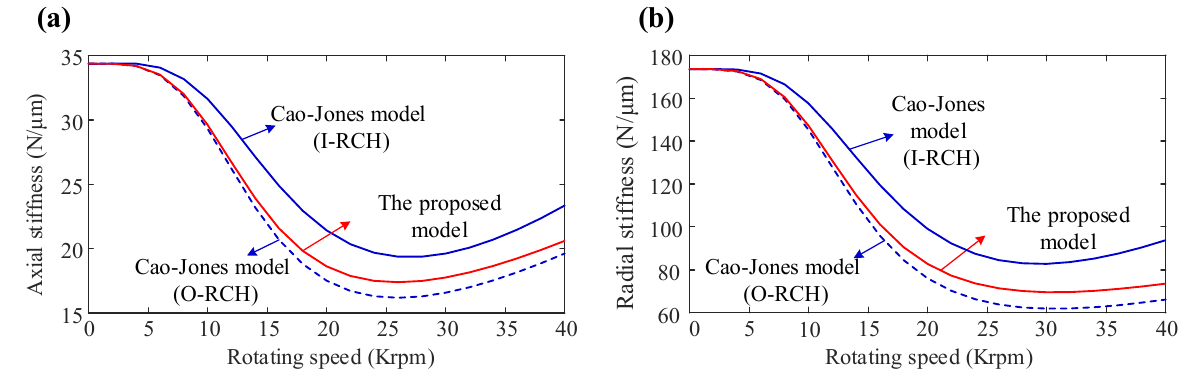
Figure 5. Comparison of bearing stiffness varying with the speed calculated by the proposed method with Cao-Jones method with the “Inner/Outer Raceway Control Hypothesis (I/O RCH)”: ( a ) axial stiffness; ( b ) radial stiffness. Table 1. T Bearing parameters of NSK B7008C, B7014C, and SKF EEB3-2Z.